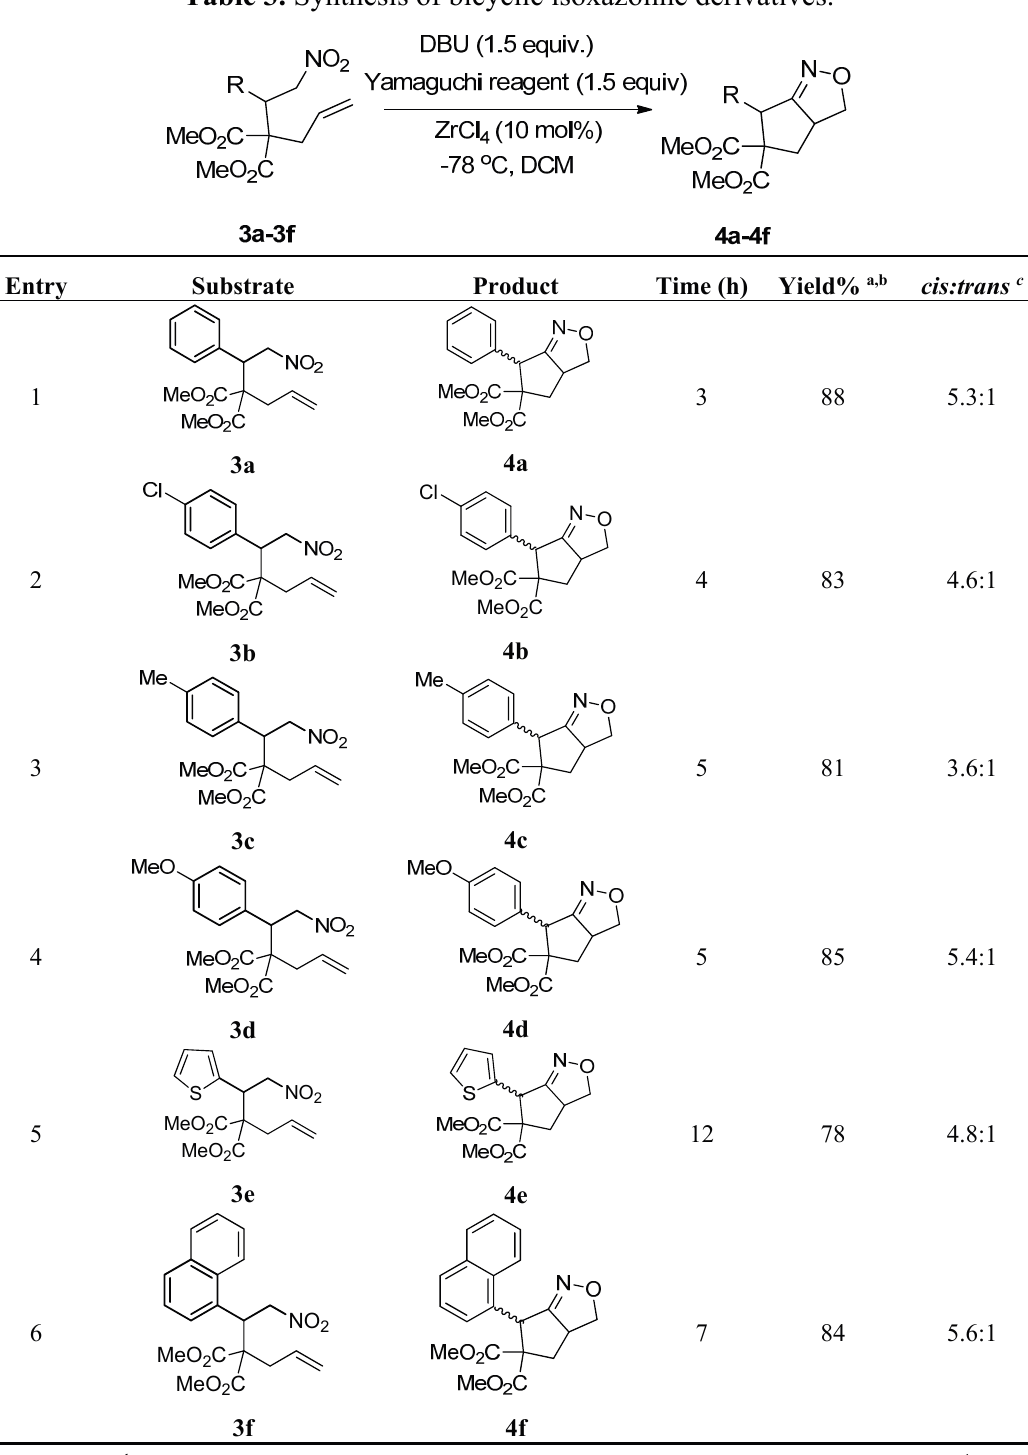
Table 3. Synthesis of bicyclic isoxazoline